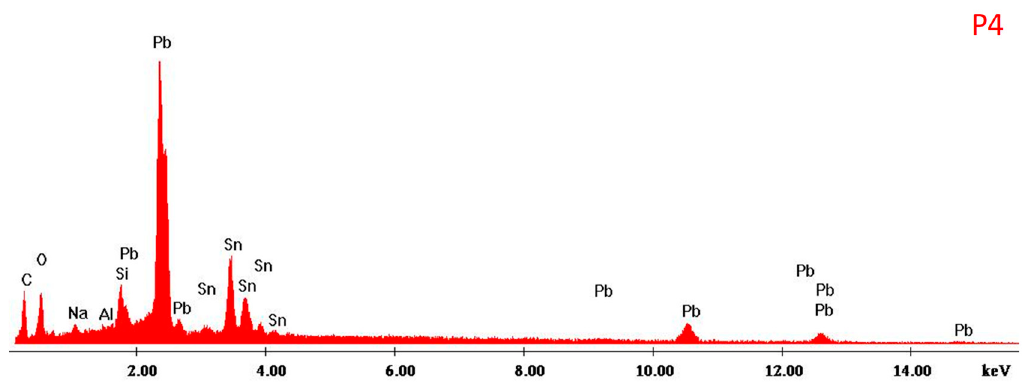
Figure 32. EDS spectrum acquired on the subhedral crystals in mixed clusters, mainly made of Pb and Sn; O, Na, Al, and Si are due to the interference of the vitreous matrix in the measurement (DMS_1Ab green natron-based Egypt I glass tessera from the Great Mosque of Damascus, Syria—unpublished data [24,25]).